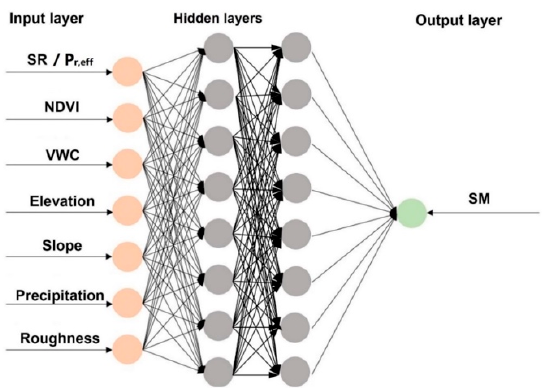
Figure 2. The back-propagation artificial neural network (BP-ANN) model to estimate monthly SM.